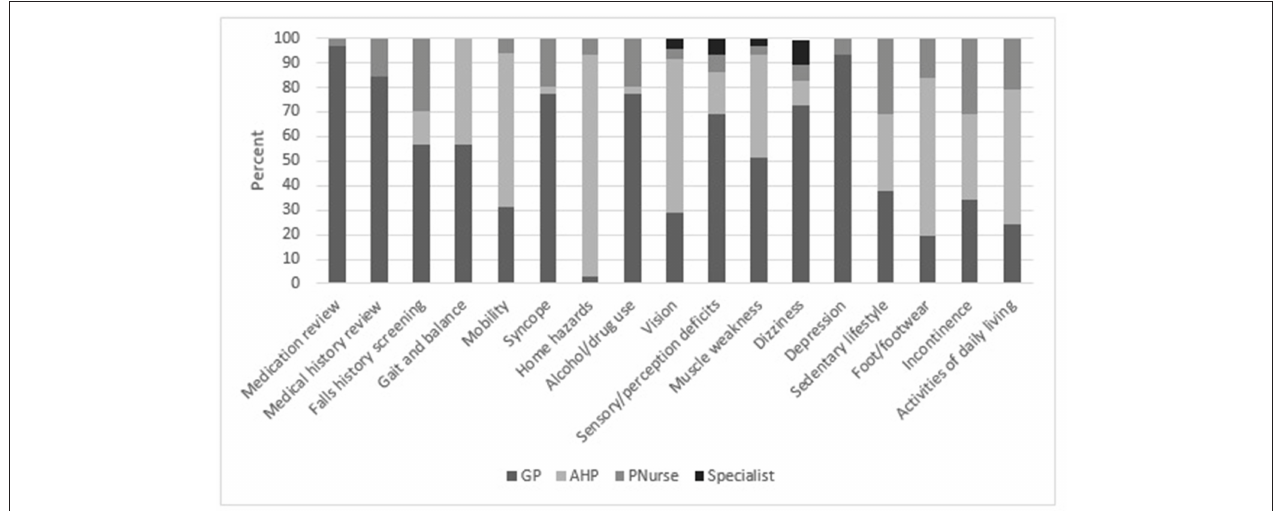
FIGURE 2 | GP opinions on who should asses each falls risk factor in older people ( N =